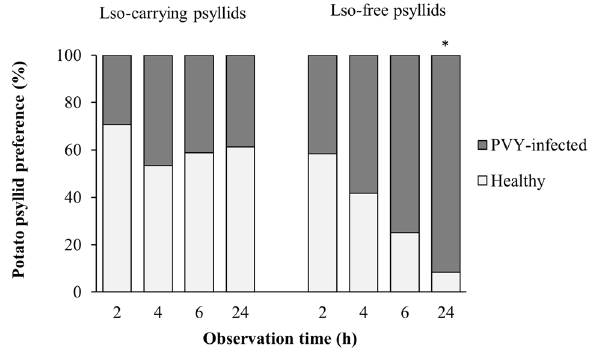
Figure 1. Percentage of Lso-carrying and Lso-free psyllids observed on healthy and PVY-infected tomato plants after 2, 4, 6, and 24 h of exposure. Overall, Lso-carrying psyllids were more likely to settle on healthy tomatoes ( P = 0.014), whereas the Lso-free psyllids settled on PVY-infected plants more frequently ( P = 0.007). Asterisk indicates significant difference within observation